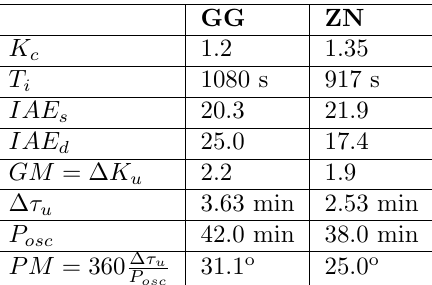
Table 2: Level control system: Performance and sta- bility robustness measures with Good Gain (GG) tuning and Ziegler-Nichols (ZN) tuning.